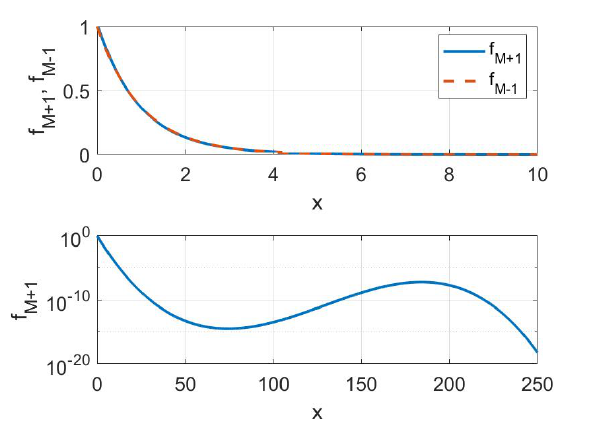
Figure 1. Stieltjes case, M = 2. f M + 1 ( ˜ µ M + 1 ) and f M − 1 (top). f M + 1 ( ˜ µ M + 1 ) in logarithmic scale (bottom).